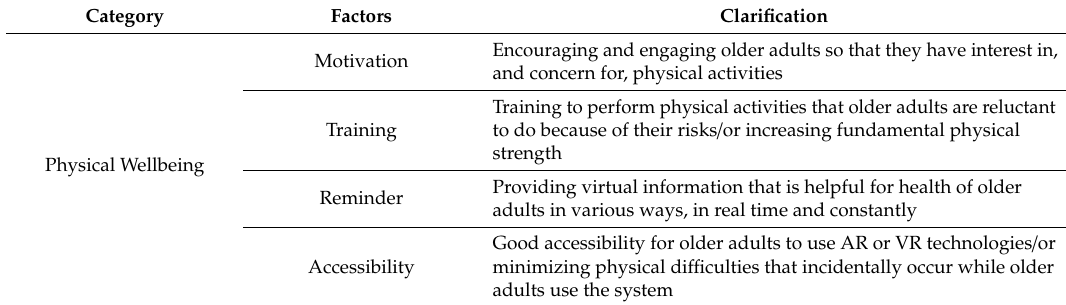
Table 2. An evaluation framework of AR and VR, focusing on promoting wellbeing of older